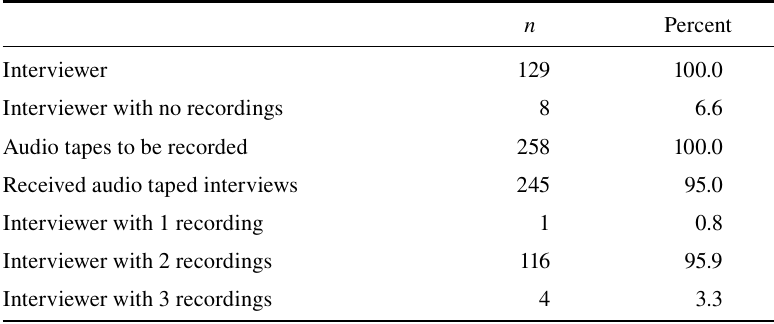
Overview of the audio recorded